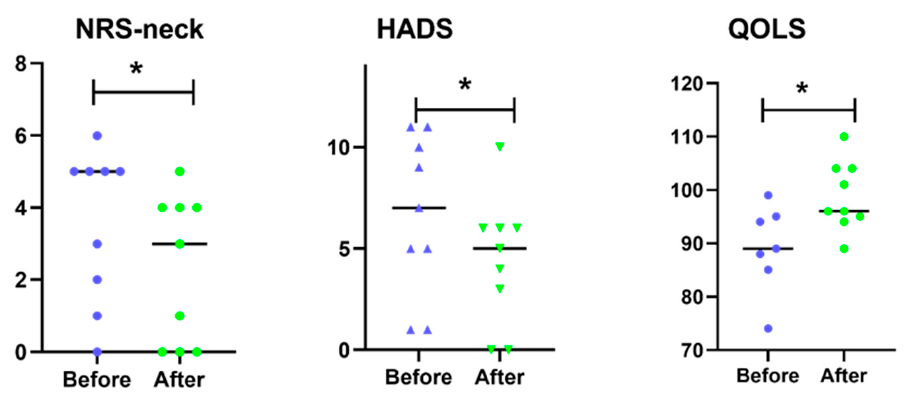
Figure 3. Statistical analysis of self-reported markers. Numeric rate scales in the neck (NRS-neck), hospital anxiety and depression scale (HADS), and quality of life scale (QOLS) for all subjects are presented in the figure. * indicates statistical significance ( p < 0.05) differences between before dynamic computer working (DCW) (blue) and after 4-weeks DCW (green) using DynaDesk. The median of the data is marked in the figure.